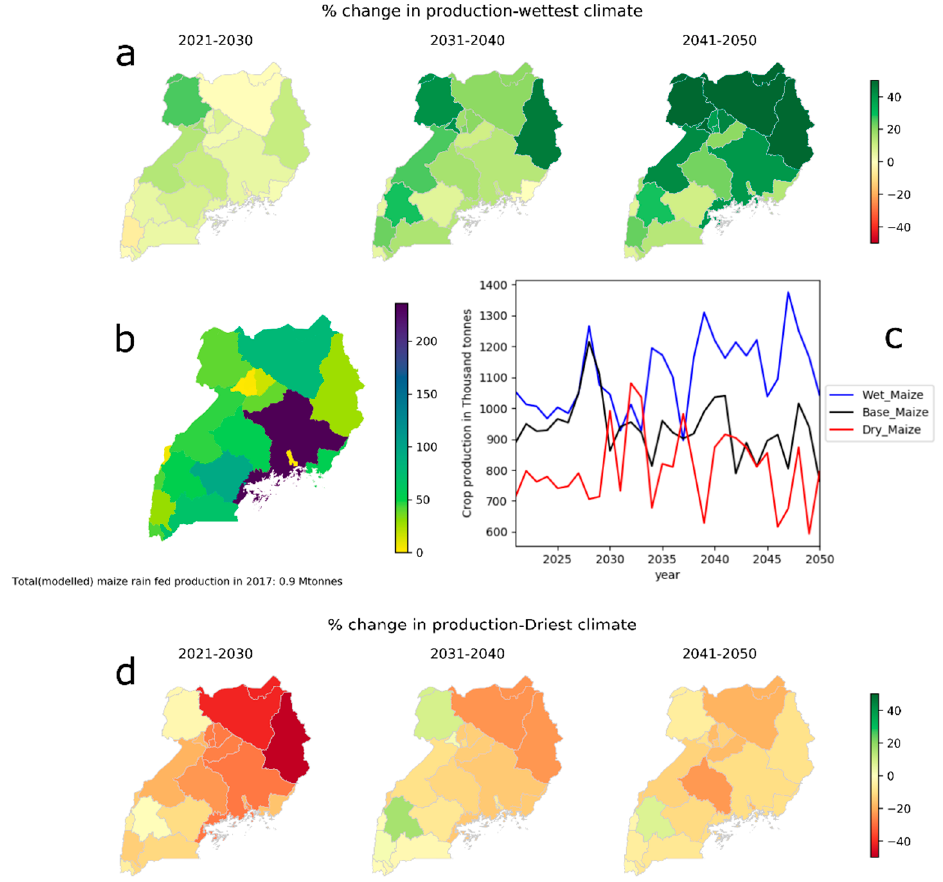
Figure 9. Climatic impact on maize production. Catchment specific di ff erences in crop production in the ( a ) wettest and ( d ) driest climate futures and the reference scenario is presented. Total modelled (catchment specific) maize production ( b ) in 2017 is provided to di ff erentiate high production zones from the rest. Parts ( a ) and ( d )should always be interpreted in relation with part ( b ). The line graph ( c ) provides the annual variation in maize production between the analyzed climate futures on a national level.